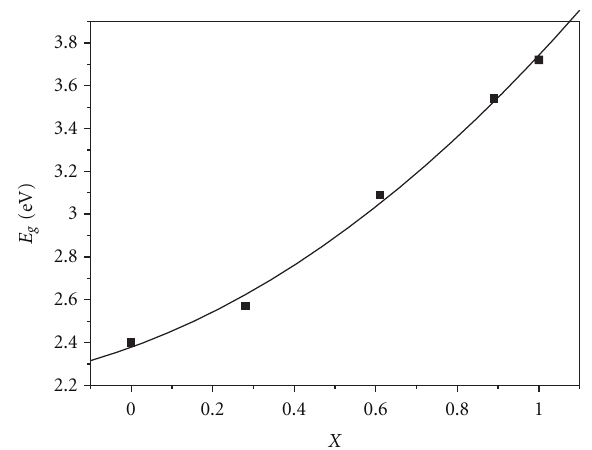
Figure 4: The variation of energy gap of the Cd 1 − x Zn x S as a function of x .